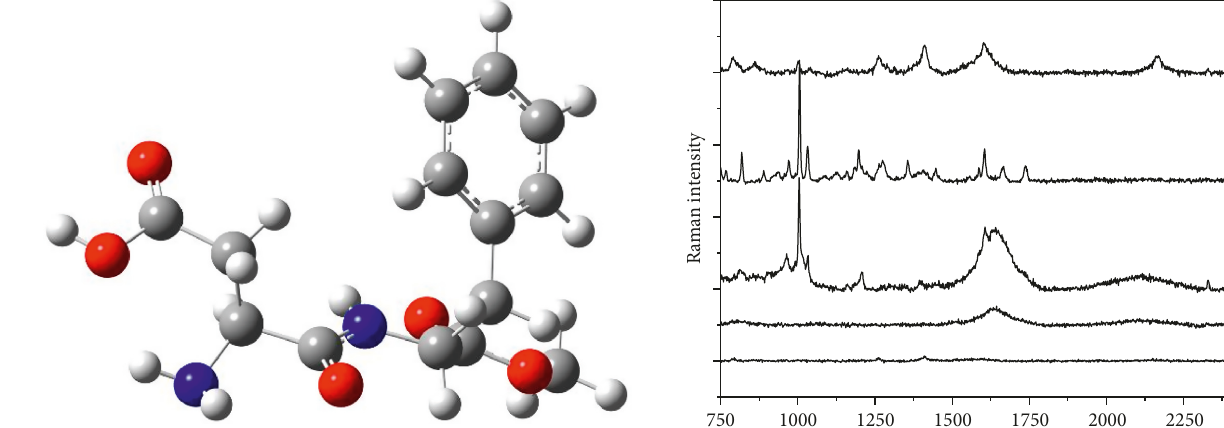
Figure 2: Theoretical structure of aspartame.